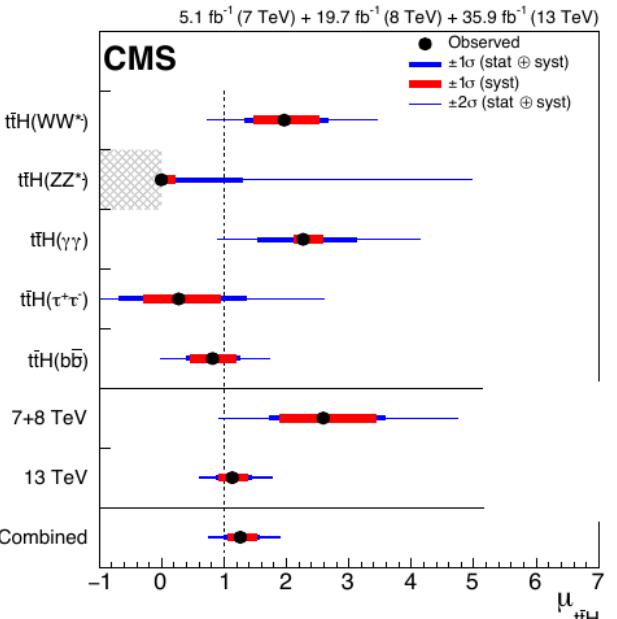
Figure 9. Observation [19] of the production of Higgs bosons associated with a top quark pair: signal strengths normalized to the standard model predictions measured for various decay modes.